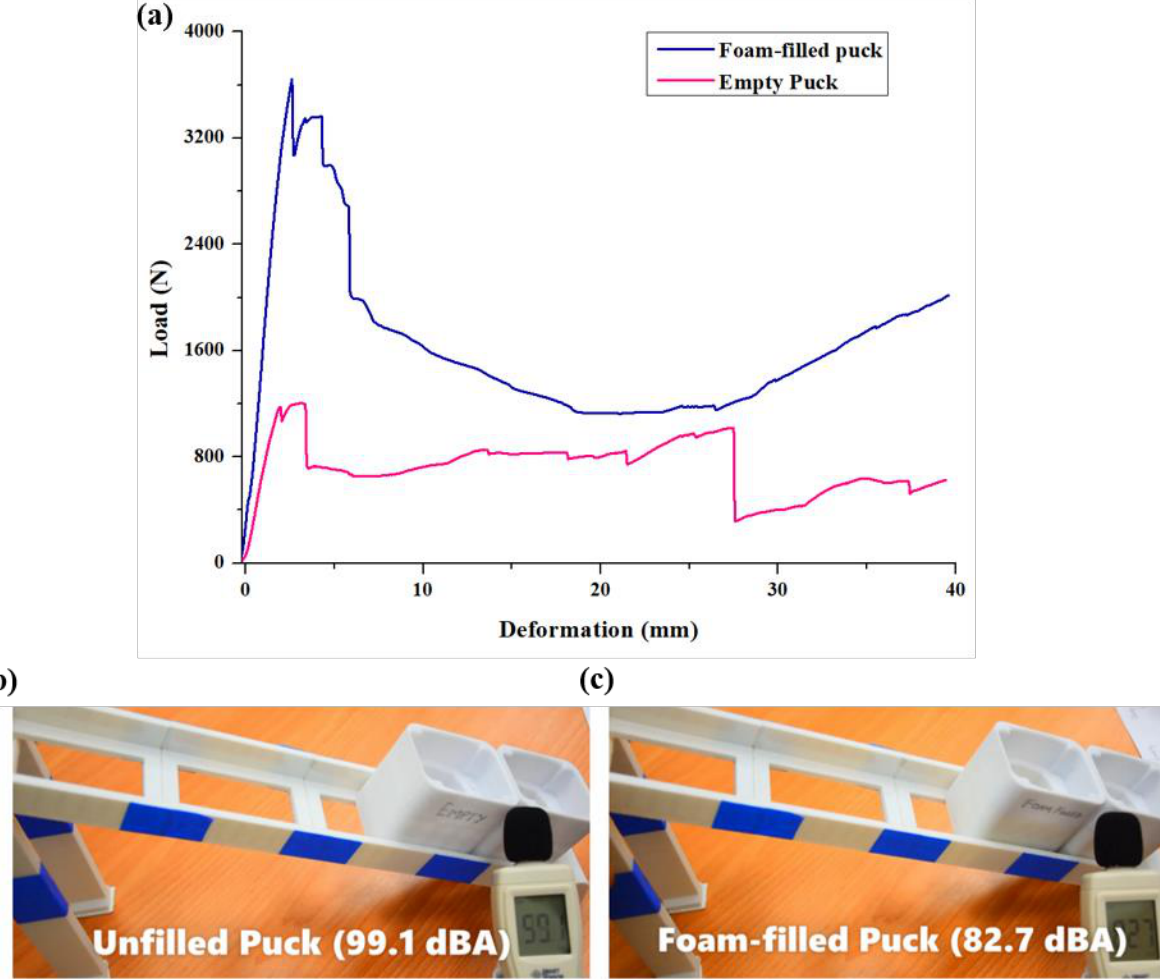
Figure 12. ( a ) Load vs deformation graph for unfilled and foam-filled puck, noise emission on collision between ( b ) unfilled puck and ( c ) foam-filled puck